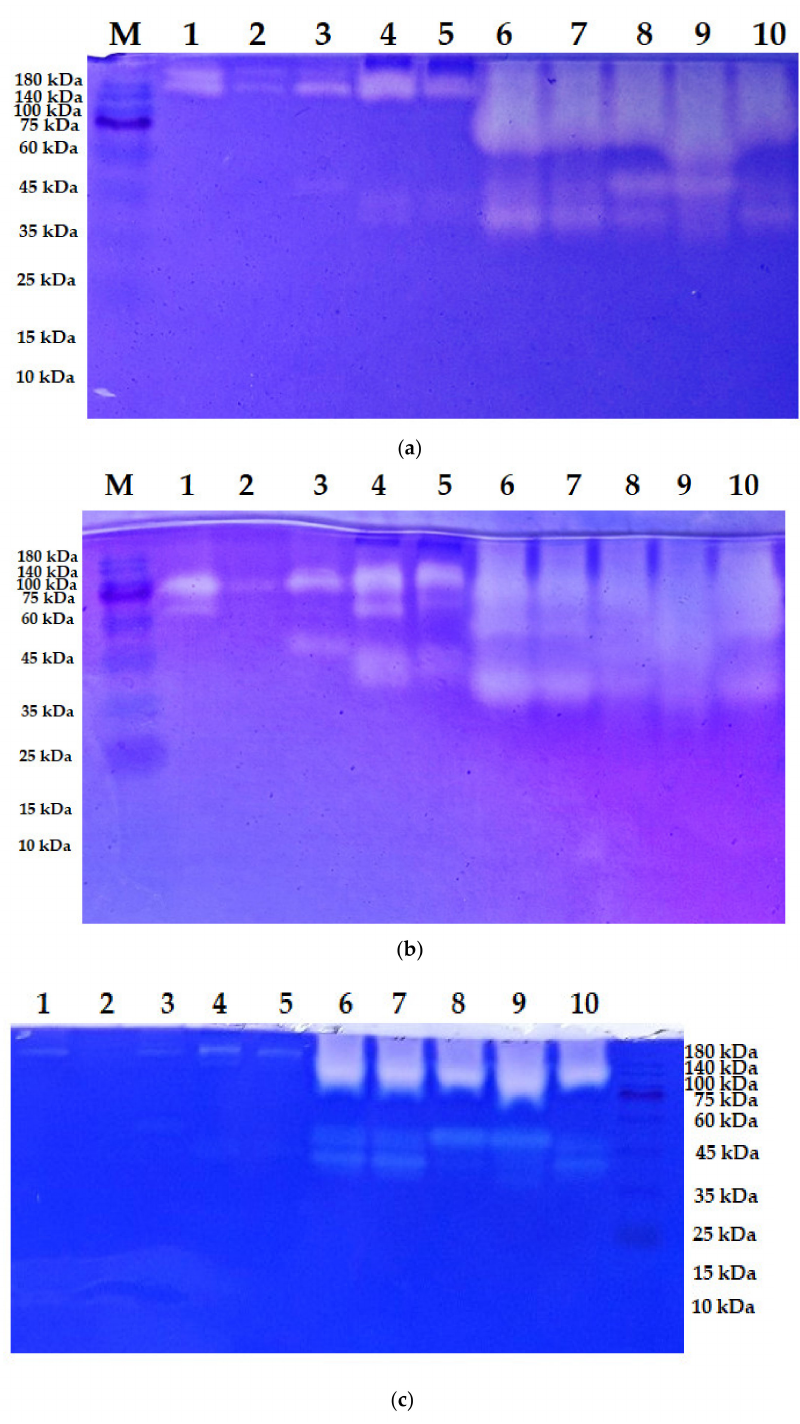
Figure 2. Detection of proteases using sodium dodecyl sulfate–polyacrylamide gel electrophoresis containing casein ( a ), gelatin ( b ), and THP ( c ). Streptomyces speibonae TKU048 was grown in the medium containing different C/N sources for 3 days to collect the culture supernatants. The C/N sources included NB (lane 1), ISP-2 (lane 2), casein (lane 3), SEW1 (lane 4), SEW2 (lane 5), SHP1 (lane 6), SHP2 (lane 7), SHP3 (lane 8), THP (lane 9), and TVP (lane 10). M, protein